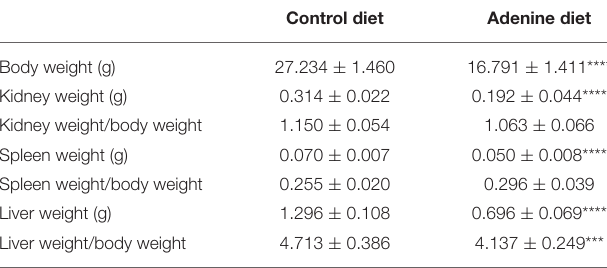
TABLE 1 | Body and organ weights.